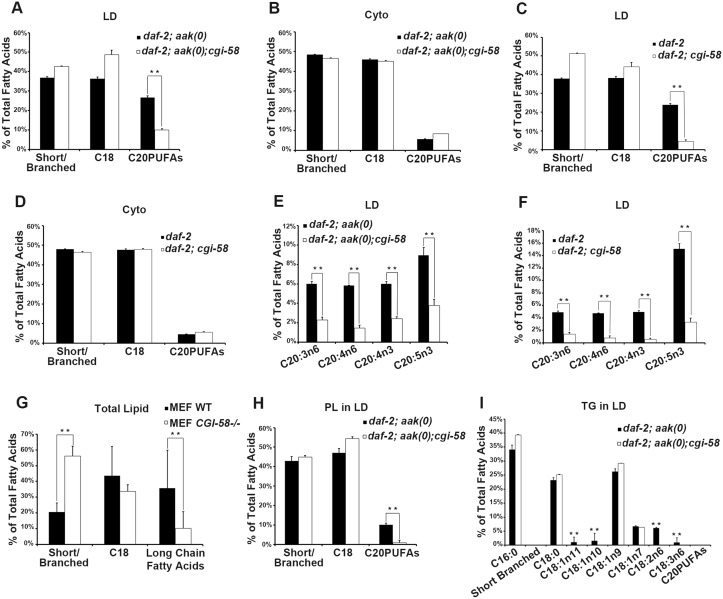
CGI-58 affect C20PUFA abundance in the lipid droplet membrane.
(A)-(D) Loss of cgi-58 in AMPK mutant (A and B) and control daf-2 (C and D) dauer larvae led to a lipid droplet-specific reduction of C20PUFAs. LD = lipid droplets. Cyto = cytoplasm. Purified lipid droplets and remaining cytoplasm were subjected to fatty acid methyl ester (FAME) extraction followed by GC/MS analysis. Short/branched fatty acids are the combined total percentage of C14:0, C15ISO, C16ISO, C16:0, C17ISO, C16:1n7 and C17Δ. C18 fatty acids are the combined total percentage of C18:0, C18:1n11, C18:1n10, C18:1n9, C18:1n7, C18:2n6 and C18:3n6. C20PUFAs are total percentage of C20:3n6, C20:4n6, C20:4n3 and C20:5n3. ** indicates statistical significance (P<0.01) and error bars indicate SD of three independent experiments in (A)-(I). (E)-(F) The amount of all major C20PUFAs were decreased in the lipid droplets of daf-2; aak(0); cgi-58
(E) and daf-2; cgi-58
(F) dauer larvae. (G) Long chain fatty acids were decreased in CGI-58 MEF mutants. Total cell lysates were subjected to FAME extraction followed by GC/MS analysis. Long chain fatty acids include fatty acids with a carbon chain longer than 20 and certain aromatic fatty acids. (H) C20PUFAs were lost from the phospholipid portion of the lipid droplets of daf-2; aak(0); cgi-58 dauer larvae. PL = phospholipid. (I) Some C18 fatty acids were completely absent in the triglyceride portion of the lipid droplets of daf-2; aak(0); cgi-58 dauer larvae. TG = triglyceride.